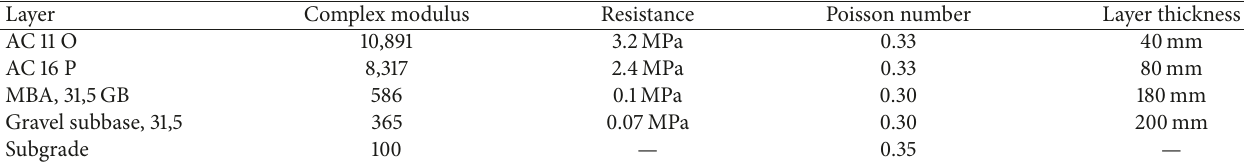
Table 1: Material characteristics of pavement layers.